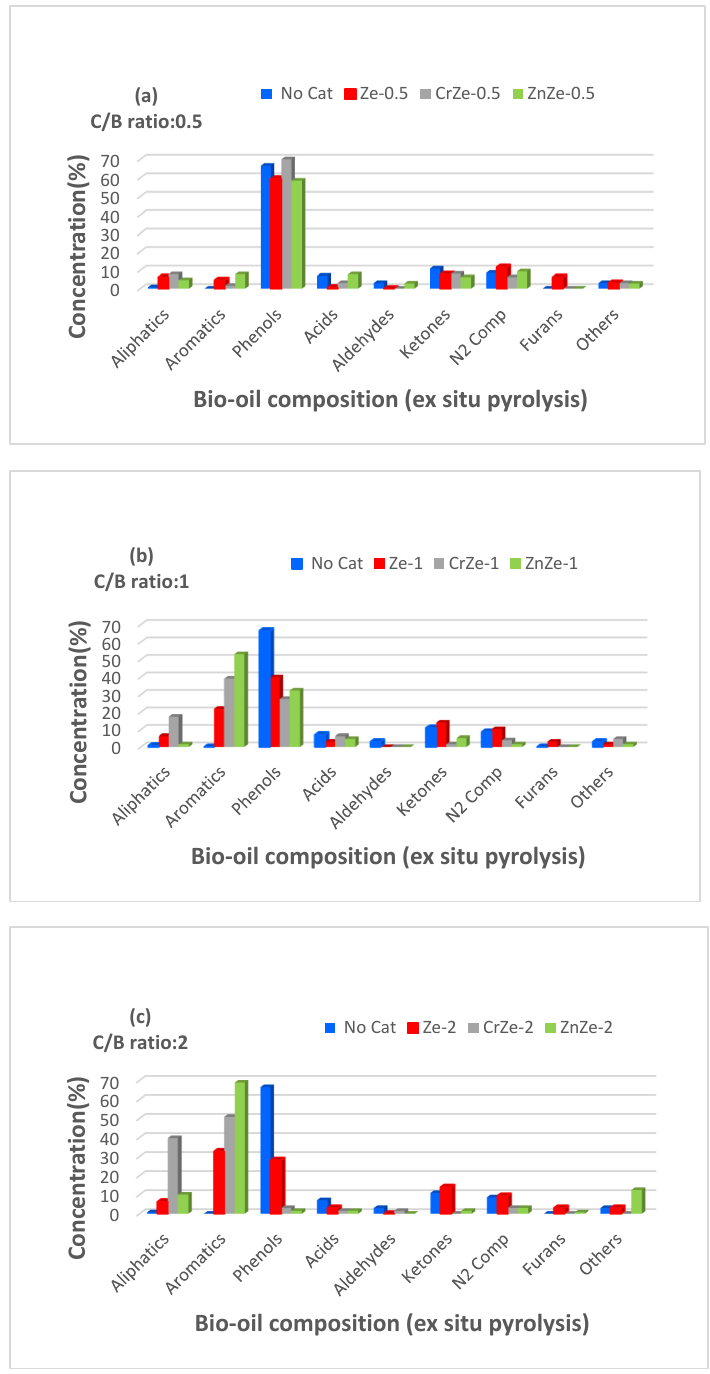
Figure 9. Bio-oil composition resulted by ex situ pyrolysis of PTCCB; ( a )—catalyst-to-biomass ratio was 0.5; ( b )—catalyst-to-biomass ratio was 1; ( c )—catalyst-to-biomass ratio was 2 (see Table 1).